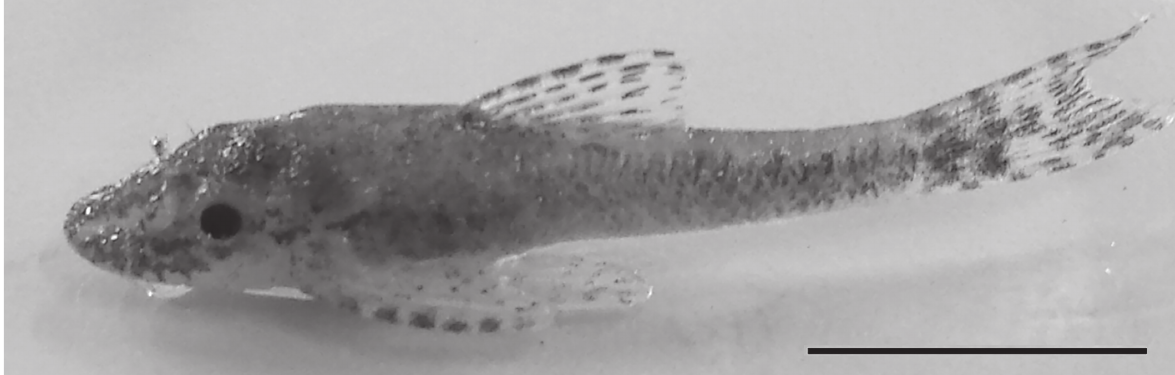
Fig. 2. Otothyropsis cf. polyodon (NUP 16171), sampled in the córrego Dourado, Mato Grosso do Sul State, Brazil. Bar = 10